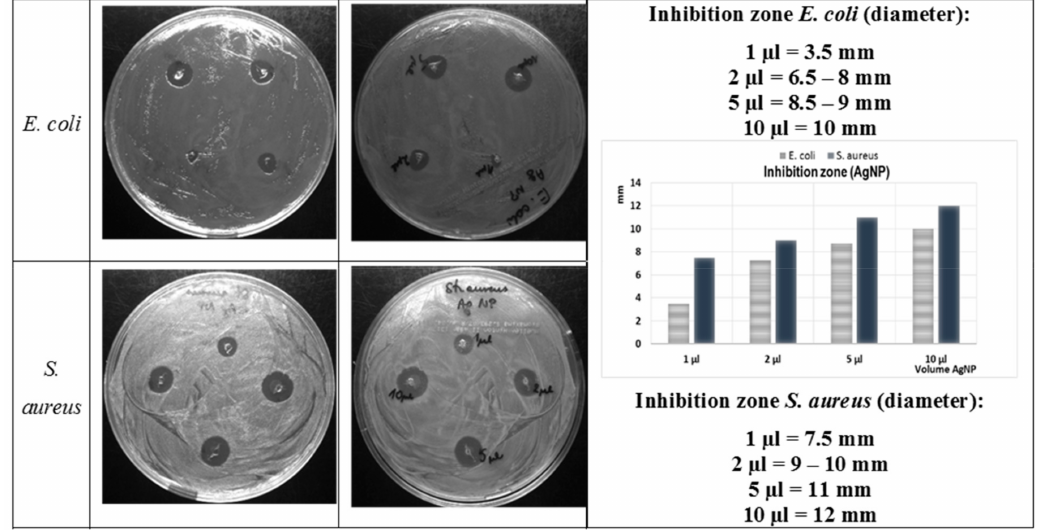
Figure 11. Photographs of the growth of E. coli and S. aureus on Mueller Hinton agar (MHA) plates with various amounts of AgNP solution and the inhibition zone size (mm) as a function of the AgNP